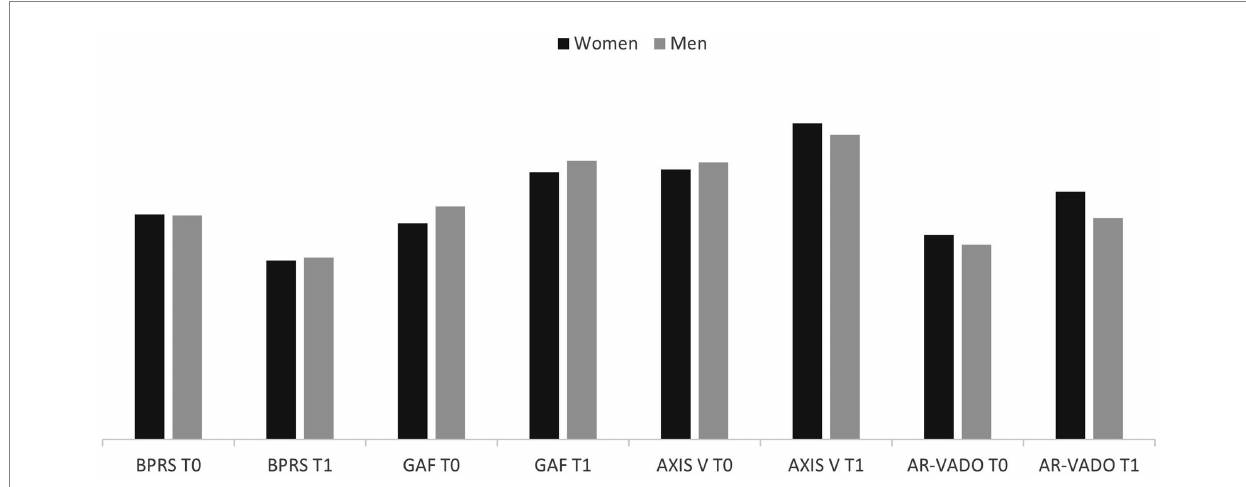
FIGURE 1 Psychometric scales scores at T0 and T1 and their comparison based on gender BPRS, Brief Psychiatric Rating Scale; GAF, Global Assessment of Functioning; Axis V, Kennedy axis V; AR-VADO, Aree Riabilitative – Rehabilitation Areas – module of the VADO (Valutazione di Abilità, Definizione di Obiettivi – Skills Evaluation, Goals Definition)